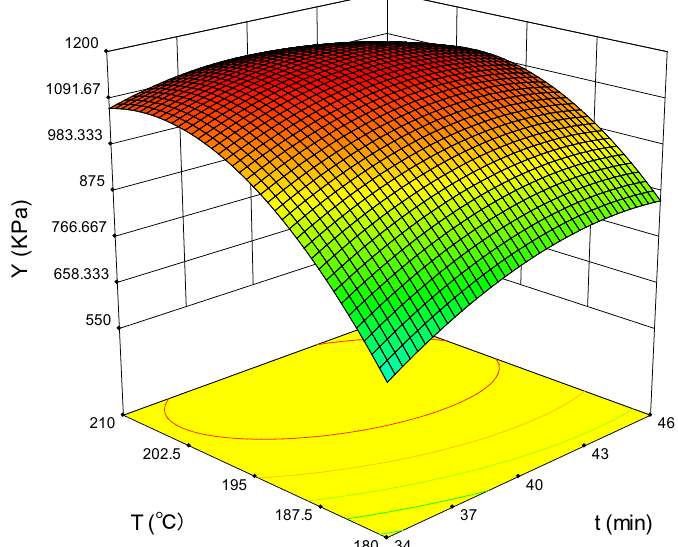
Figure 3. Response surface showing Y as a function of treatment temperature (T) and curing time (t).